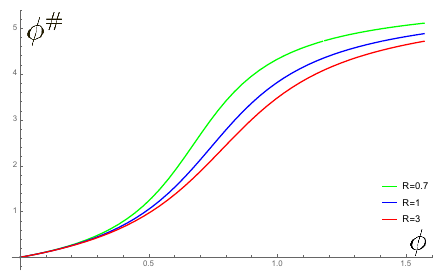
Figure 10 . Location of the #-image point on the initial time slice for di(cid:11)erent values of the horizon